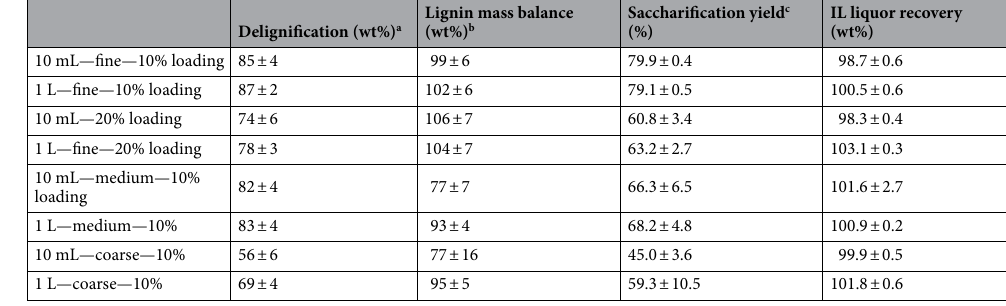
Table 4. Key pretreatment outcomes at 10 mL vs 1 L scale as a function of particle size. a Based on feedstock lignin content (AIL + ASL), as determined by compositional analysis of untreated Miscanthus. b Sum of residual lignin in pulp and isolated lignin yield. c Glucose yield released from pulps as recovered after ethanol washing (without further size reduction).